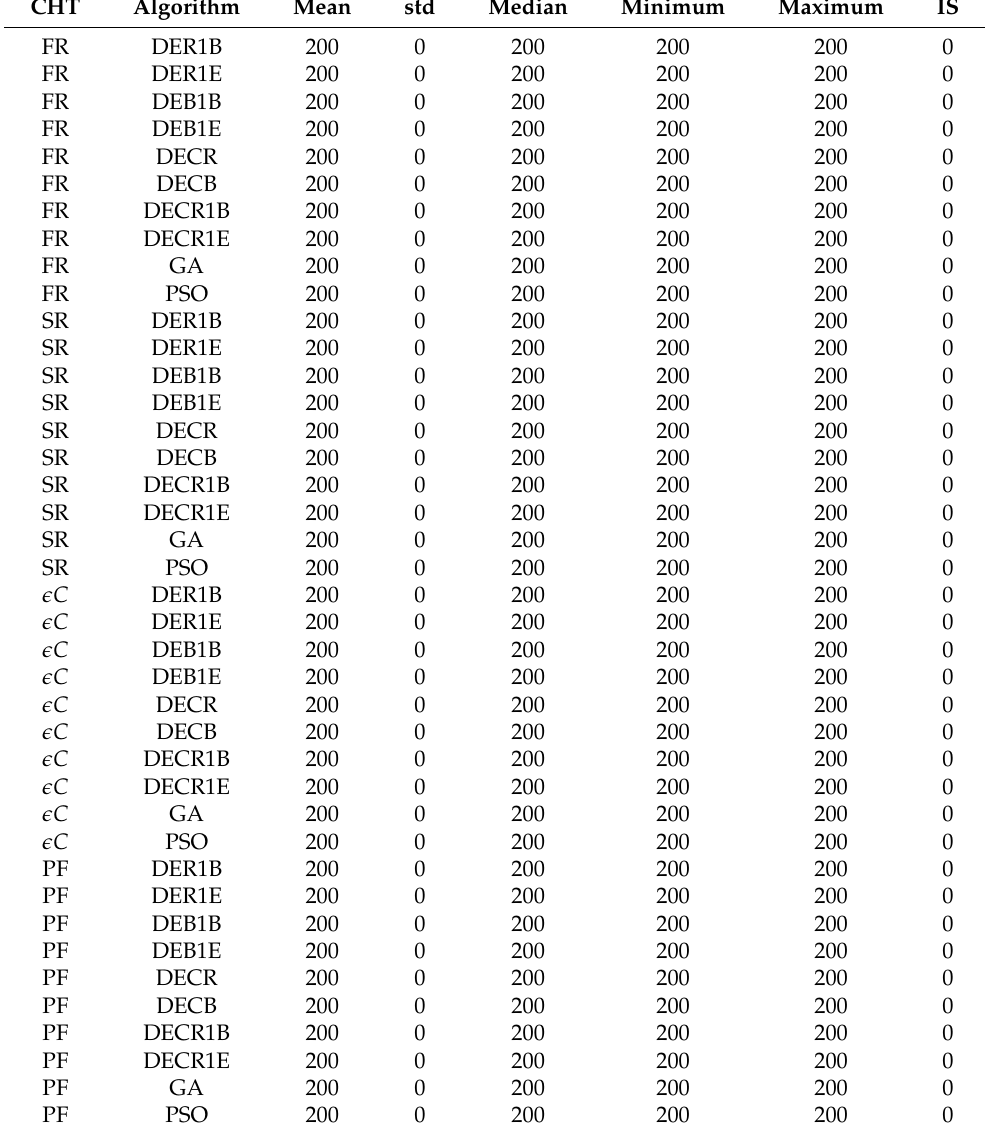
Table A16. EVALS descriptive statistics for study case 1: Four-bar linkage mechanism. IS means the number of infeasible solutions through the